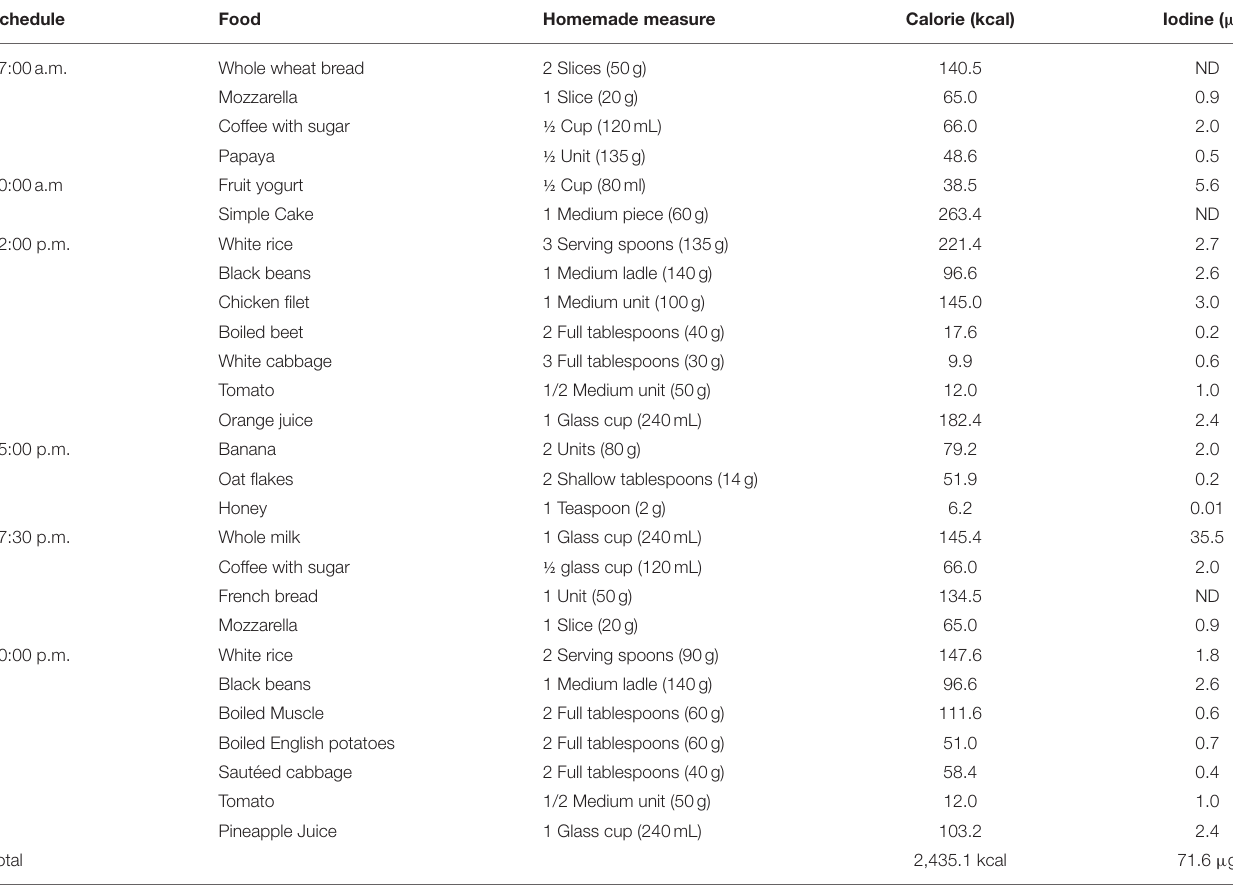
TABLE 1 | Food plan for a pregnant